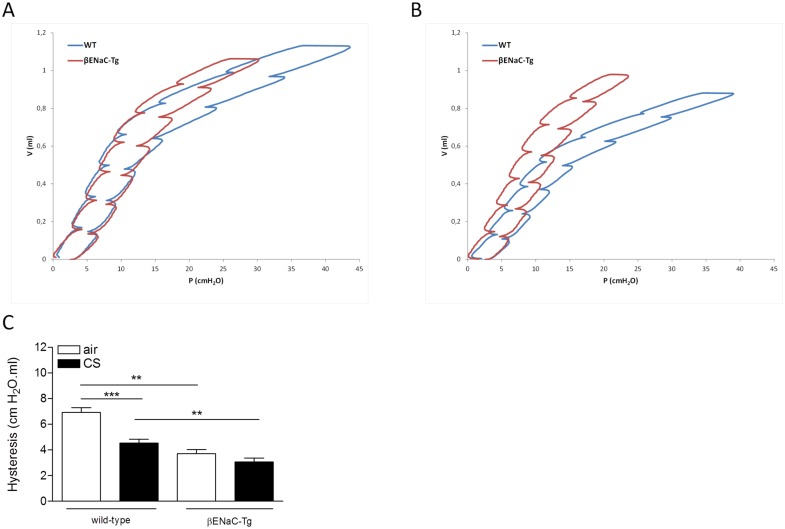
Pressure-Volume loops of air- and CS-exposed mice.
(A) Representative PV loops of air-exposed WT (black) and βENaC-Tg (red) mice. (B) Representative PV loops of CS-exposed WT (black) and βENaC-Tg (red) mice. (C) Area of PV loop or hysteresis. *p<0.05, **p<0.01, ***p<0.001.